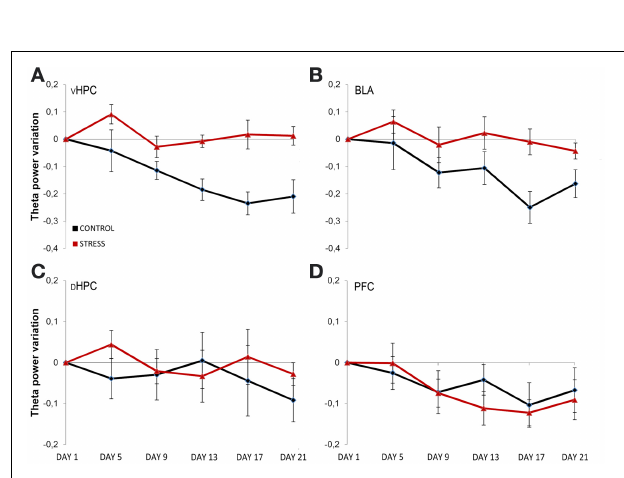
FIGURE 4 | Temporal evolution of theta power variation from initial exposure with familiarization. Theta power variation during all exposures to the OF arena (day 5, day 9, day 13, day 17, and day 21) relative to theta power in the initial exposure (day 1, origin) from activity recorded from ventral hippocampus (vHPC) (A) , basolateral amygdala (BLA) (B) , dorsal hippocampus (dHPC) (C) , and medial prefrontal cortex (PFC) (D) . Theta power decreased in the vHPC and BLA in control rats with familiarization; the same decrease was not observed in stressed rats. No differences were observed between the groups for dHPC and PFC theta power variation with familiarization despite a trend for PFC theta power decrease on both groups. Also note that the second exposure to the OF arena (which corresponded to 4 days of exposure to stressors on stress group rats) showed an incremental effect of stress on theta power as vHPC activity increased from the first exposure on stressed rats only. Error bars: ±